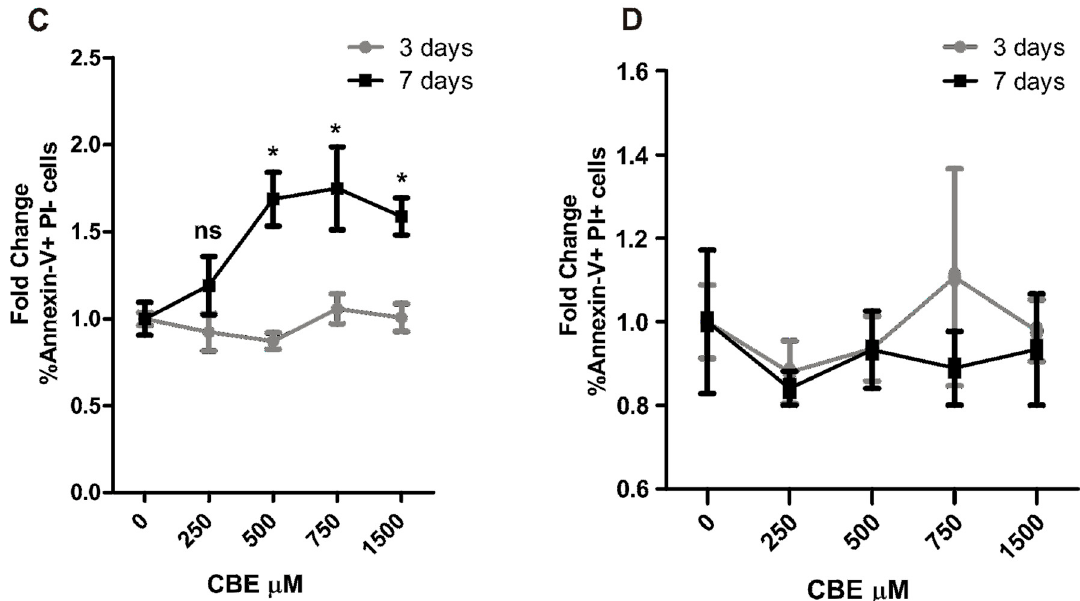
Figure 3. GCase deficiency induces osteocyte apoptosis. Osteocytes were treated for 7 and 14 days with CBE, and apoptosis was evaluated by Annexin-V + ( A ) and terminal deoxynucleotidyl transferase dUTP nick end labeling (TUNEL) ( B ). The fold change between CBE and control cells for the percentage of Annexin-V + propidium iodide (PI) − osteocytes ( A ) and the percentage of TUNEL + nuclei ( B ) are shown. Results are presented as the fold change for CBE treatment against control conditions. Data are expressed as mean ± SD ( n = 5) and are representative of three independent experiments performed. * p < 0.05, ** p < 0.01 t -test. CBE toxicity was evaluated by Annexin-V staining in osteocytes treated with different concentrations of CBE for three and 7 days. The fold change between CBE and control cells for the percentage of Annexin-V + PI − ( C ) and Annexin-V + PI + ( D ) osteocytes is shown. Data are expressed as mean ± SD ( n = 5) and are representative of three independent experiments performed. * p < 0.05 one-way ANOVA. ns, non-significant.